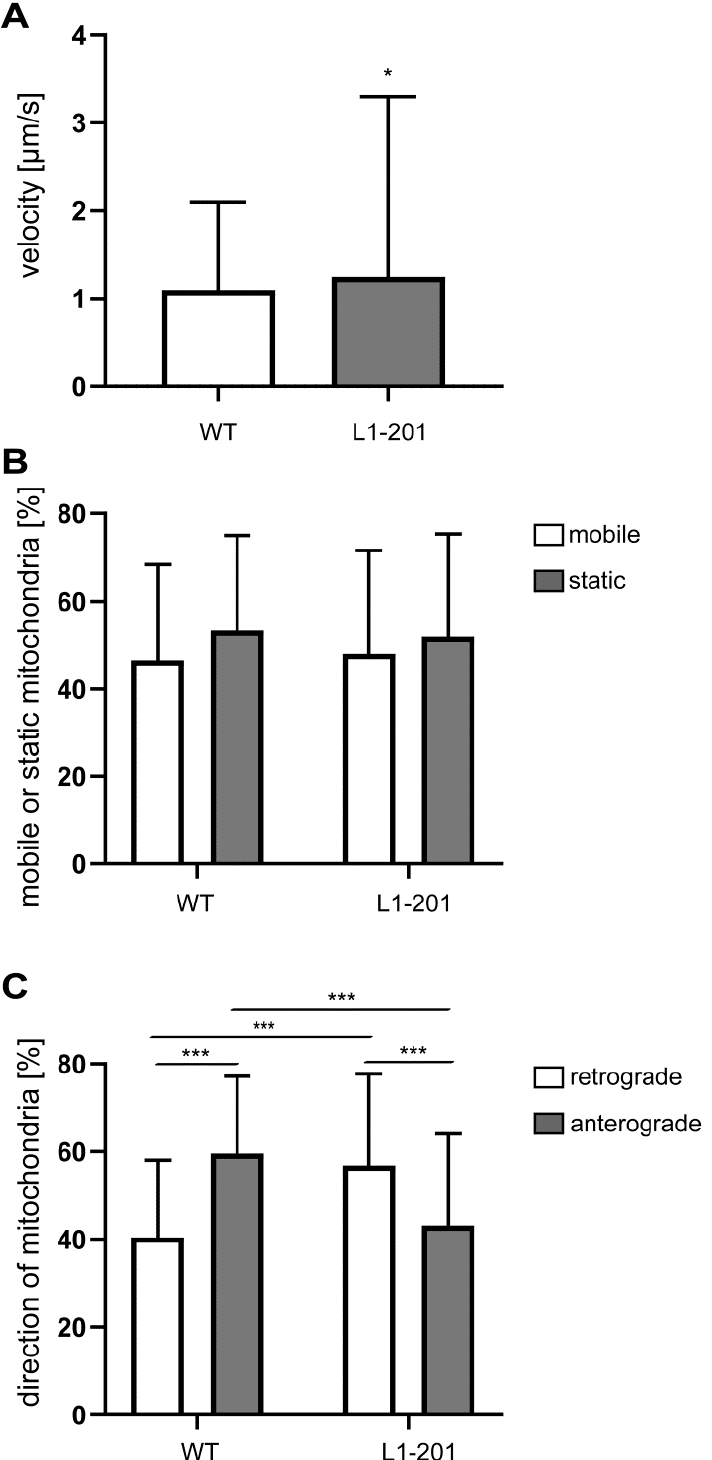
Figure 5. Mitochondria from L1/201 mice showed normal mobility and enhanced velocity but moved more retrogradely than mitochondria from wild-type neurons. Mitochondrial velocity ( A ), mobility ( B ) and transport direction ( C ) were analyzed in cultured cerebellar neurons from 7-day-old male L1-201 mice and wild-type littermates. Mean values ± SD are shown; n = 3. * p < 0.05, *** p < 0.005 (velocity: Mann–Whitney test; mobility: two-way ANOVA with Tukey ´ s post-hoc test; direction: Kruskal–Wallis test with Dunn’s multiple comparison test).